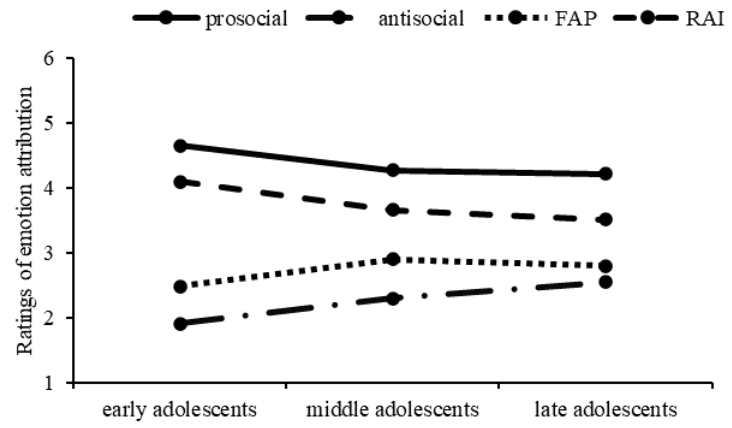
Figure 3. Ratings of Emotion Attribution in Three Age